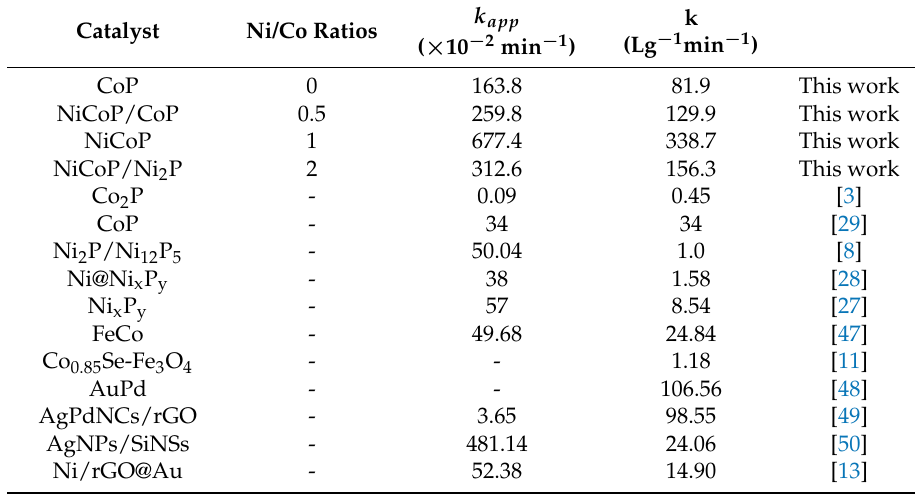
Figure 9. ( a ) The plots of ln(C t /C 0 ) versus the reaction time for the reduction of 4-NP catalyzed by CoP, NiCoP/CoP, NiCoP, and NiCoP. ( b ) The catalytic efficiency varies with the Ni/Co molar ratio. ( c ) Effect of catalyst dosage on reduction of 4-NP catalyzed by NiCoP catalysts in the presence of NaBH 4 . Table 1. Comparison of the catalytic k app and k in this work with other phosphide catalysts previously reported for the reduction of